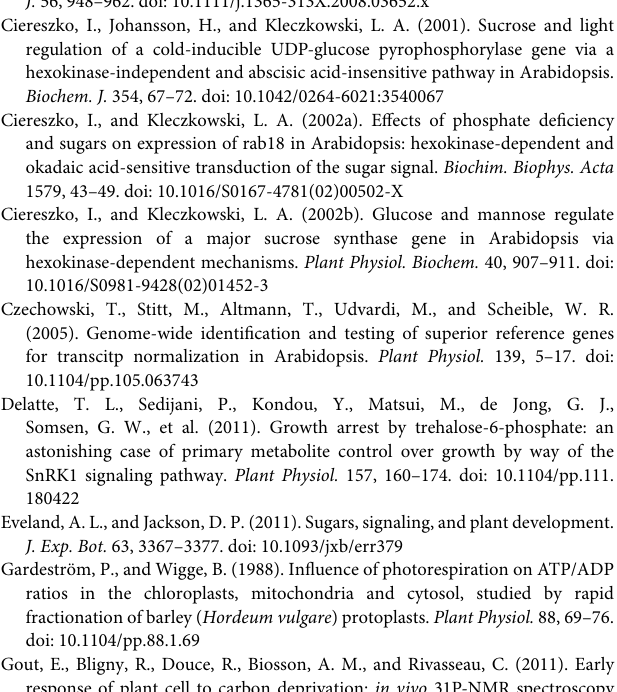
content (Glc in blue, Fru in red, and Suc in green) and gene expression were drawn for roots (left column) and shoots (right column) of 13 days old A. thaliana